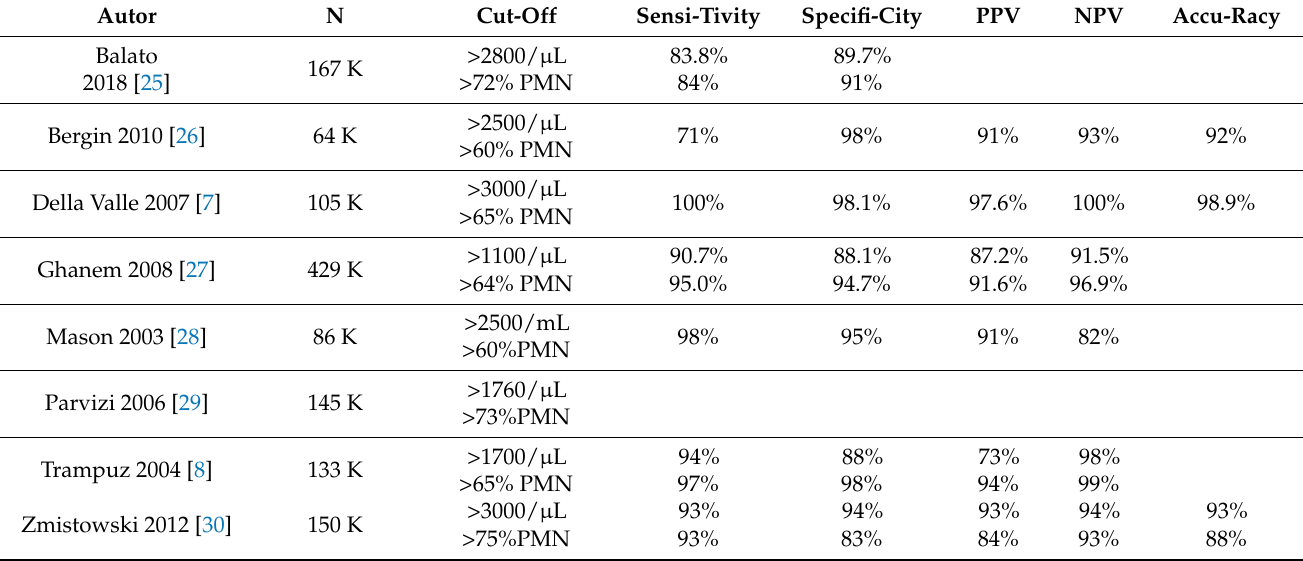
Table 1. Overview of the literature of cell count analysis in the aspirate for the diagnosis of periprosthetic joint infection. N = number of joints, H = hip arthroplasty, K = knee arthroplasty, 2 w = duration of symptoms of two weeks, PPV = Positive Predictive Value, NPV = Negative Predictive